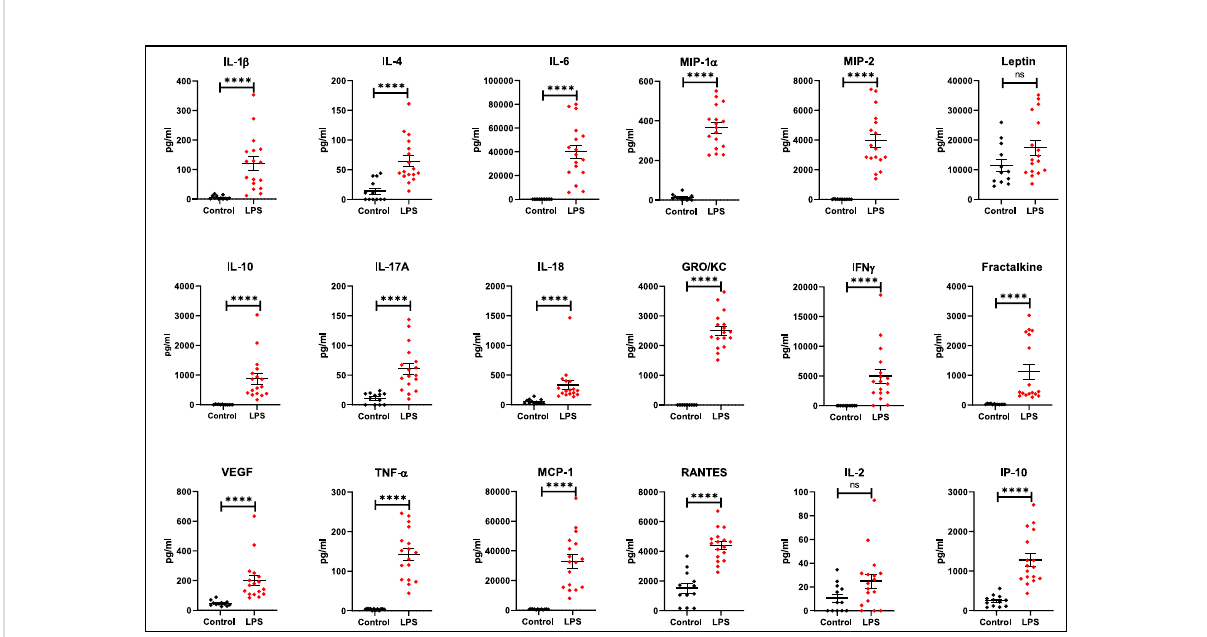
FIGURE 2 Expression of serum cytokines and chemokines. Increased expression (pg/mL) of various cytokines and chemokines is seen after LPS treatment (Control n=12, LPS n=17). Statistical analysis was performed using unpaired Mann Whitney test to evaluate changes in serum cytokines and chemokines between controls and LPS groups. Mean with SEM are shown. p-values <0.01 are considered statistically signi fi cant. ****p<0.0001, not signi fi cant